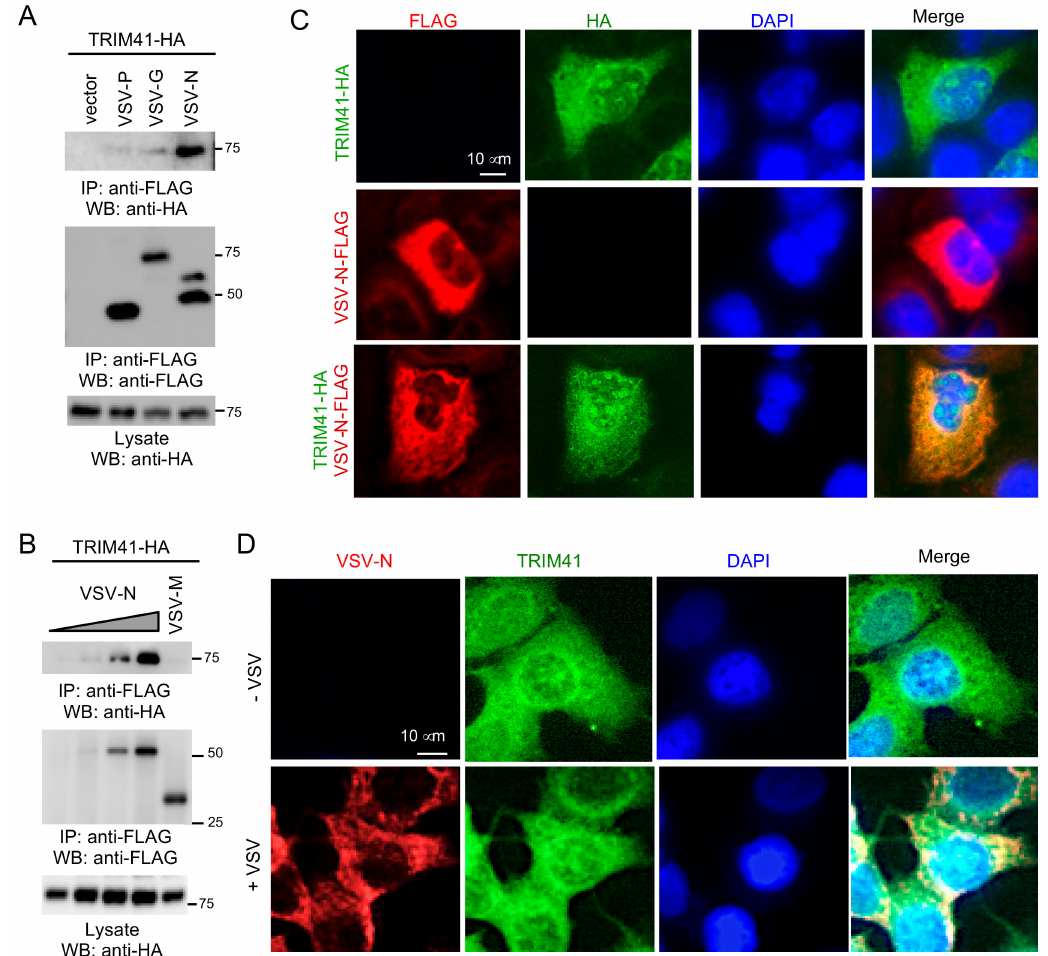
Figure 3. TRIM41 co-localizes and interacts with the N protein of VSV. ( A ) HA-tagged TRIM41 (TRIM41-HA) was co-transfected with FLAG-tagged phosphoprotein (P), glycoprotein (G), or nucleoprotein (N) of VSV into HEK293 cells. Cells were treated with 1 µ M proteasome inhibitor MG132 to prevent VSV protein from degradation. Cell lysates were immunoprecipitated with the anti-FLAG antibody and then blotted as indicated. ( B ) TRIM41-HA was co-transfected with FLAG-tagged matrix protein (M) or di ff erent doses of nucleoprotein (N) of VSV into HEK293 cells. Cells were treated with 1 µ M proteasome inhibitor MG132 to prevent VSV protein from degradation. Cell lysates were immunoprecipitated with the anti-FLAG antibody and then blotted as indicated. ( C ) A549 cells were transfected with TRIM41-HA and FLAG-tagged VSV-N (VSV-N-FLAG). Cells were treated with 1 µ M MG132 to prevent VSV protein from degradation. Red: FLAG; Green: HA; Blue: DAPI, a nuclear stain. ( D ) A549 cells were mock-infected or infected with VSV. Cells were treated with 1 µ M MG132 to prevent VSV-N from degradation. After 24 h, cells were fixed with cold methanol and incubated with anti-VSV-N and anti-TRIM41 antibodies. Red: VSV-N; Green: TRIM41; Blue: DAPI, a nuclear